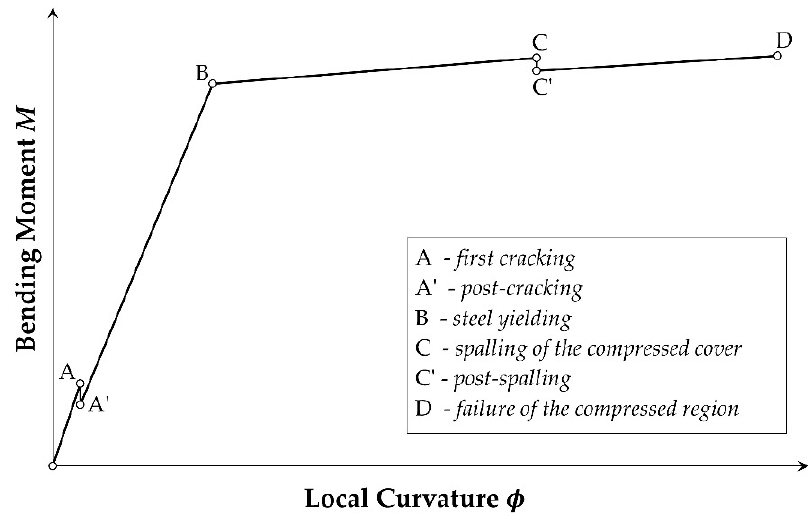
Figure 3. Typical moment–curvature diagram represented considering the buckling effects.